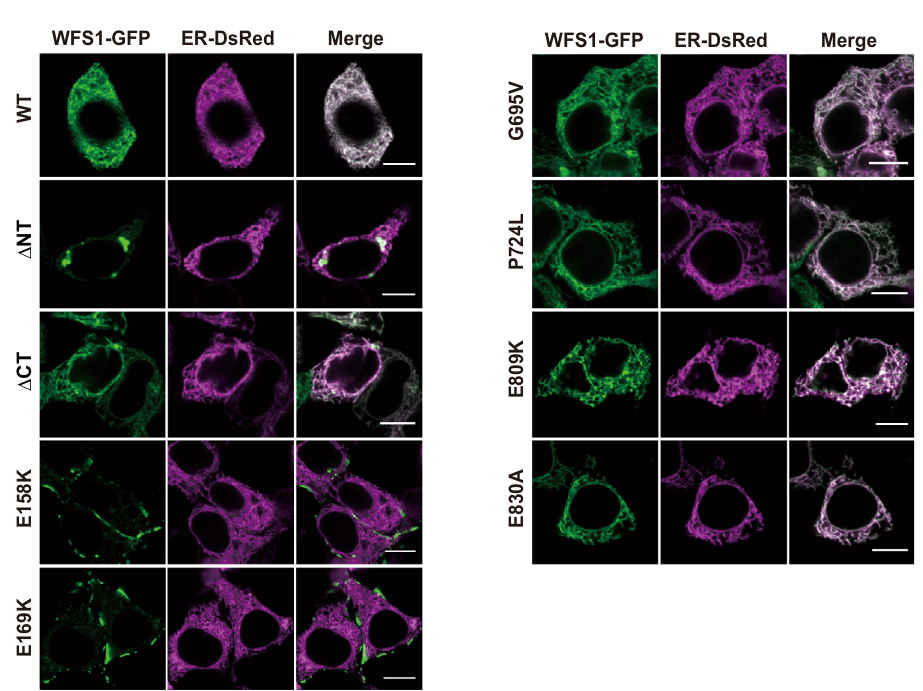
Fig. 6 The localization of different mutant WFS1 proteins in HEK-293T cells. Pairwise expression of KDEL-Dsred and mutant WFS1-GFP (WT, Δ NT, Δ CT, E158K, E169K, G695V, P724L, E809K, and E830K) revealed that the Δ NT, E158K, or E169K mutation severely disrupted ER localization of WFS1. n = 3 independent experiments. Scale bar, 10 μ granule cargo traf fi cking, which is a speci fi c secretory pathway in pancreatic β -cells. Pathogenic mutations (E158K and E169K) in the N-terminal segment disrupt ER localization and its interac- tion with SEC24, and pathogenic mutations (G695V, P724L, E809K, and E830A) in the C-terminal segment disrupt the recognition of cargo proteins, impairing the sorting of cargo proteins into the COPII vesicles. Whereas blockade of COPII vesicle-mediated cargo traf fi cking induces ER stress and apoptosis in pancreatic β -cells 35 . Therefore, our data indicated that the impaired transport of vesicular cargo proteins underlies diabetes caused by WFS1 pathogenic mutations. In addition to juvenile- onset diabetes, one of the major characteristics of Wolfram syn- drome is neurodegeneration 9 , and WFS1 has been shown to be highly expressed in the brain 14 . Thus, it will be of interest to verify whether WFS1 also acts as a receptor to sort neuropeptide cargo proteins into the COPII vesicles in neuronal cells. Recently, it has been reported that de fi ciency of YIPF5 in pancreatic β -cell models gave rise to proinsulin retention and ER stress 36 , which is